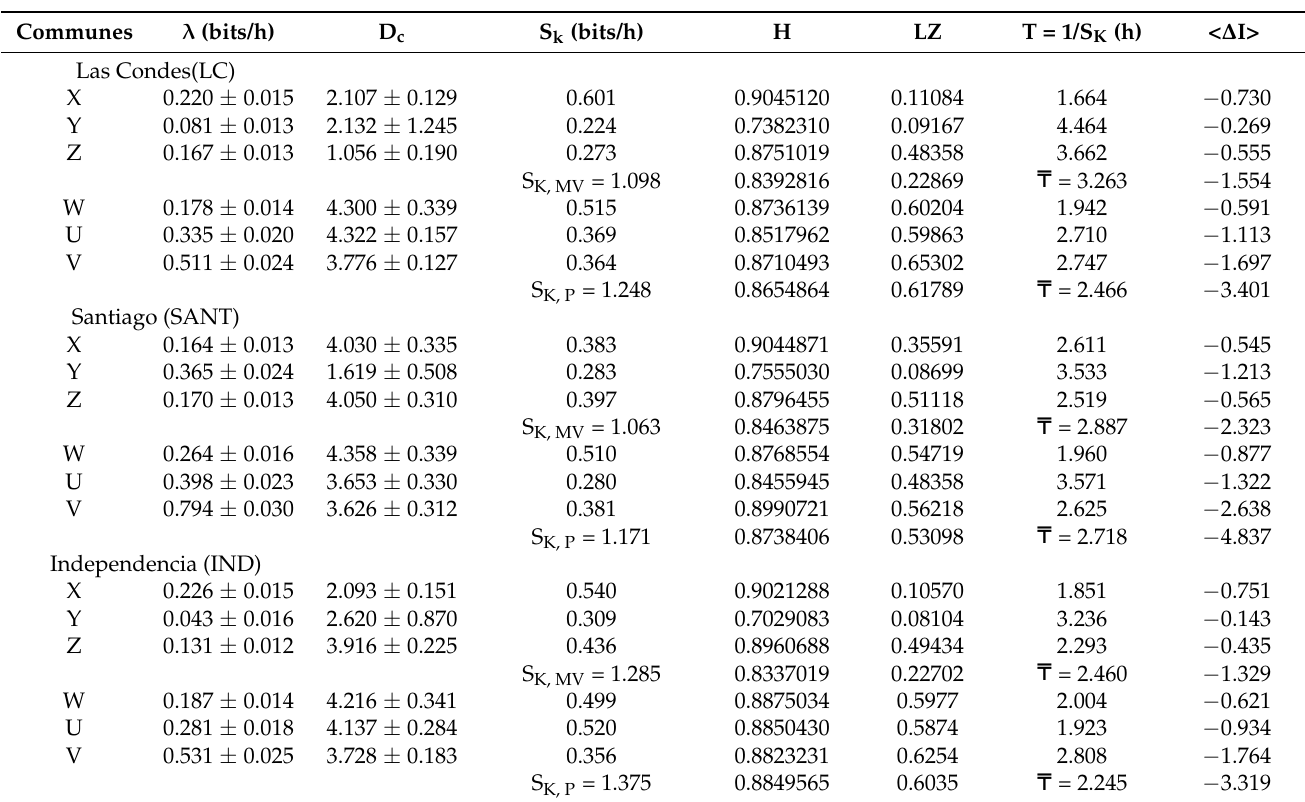
Table 3. Nonlinear parameters [52] by commune and for accumulated sick people, meteorological